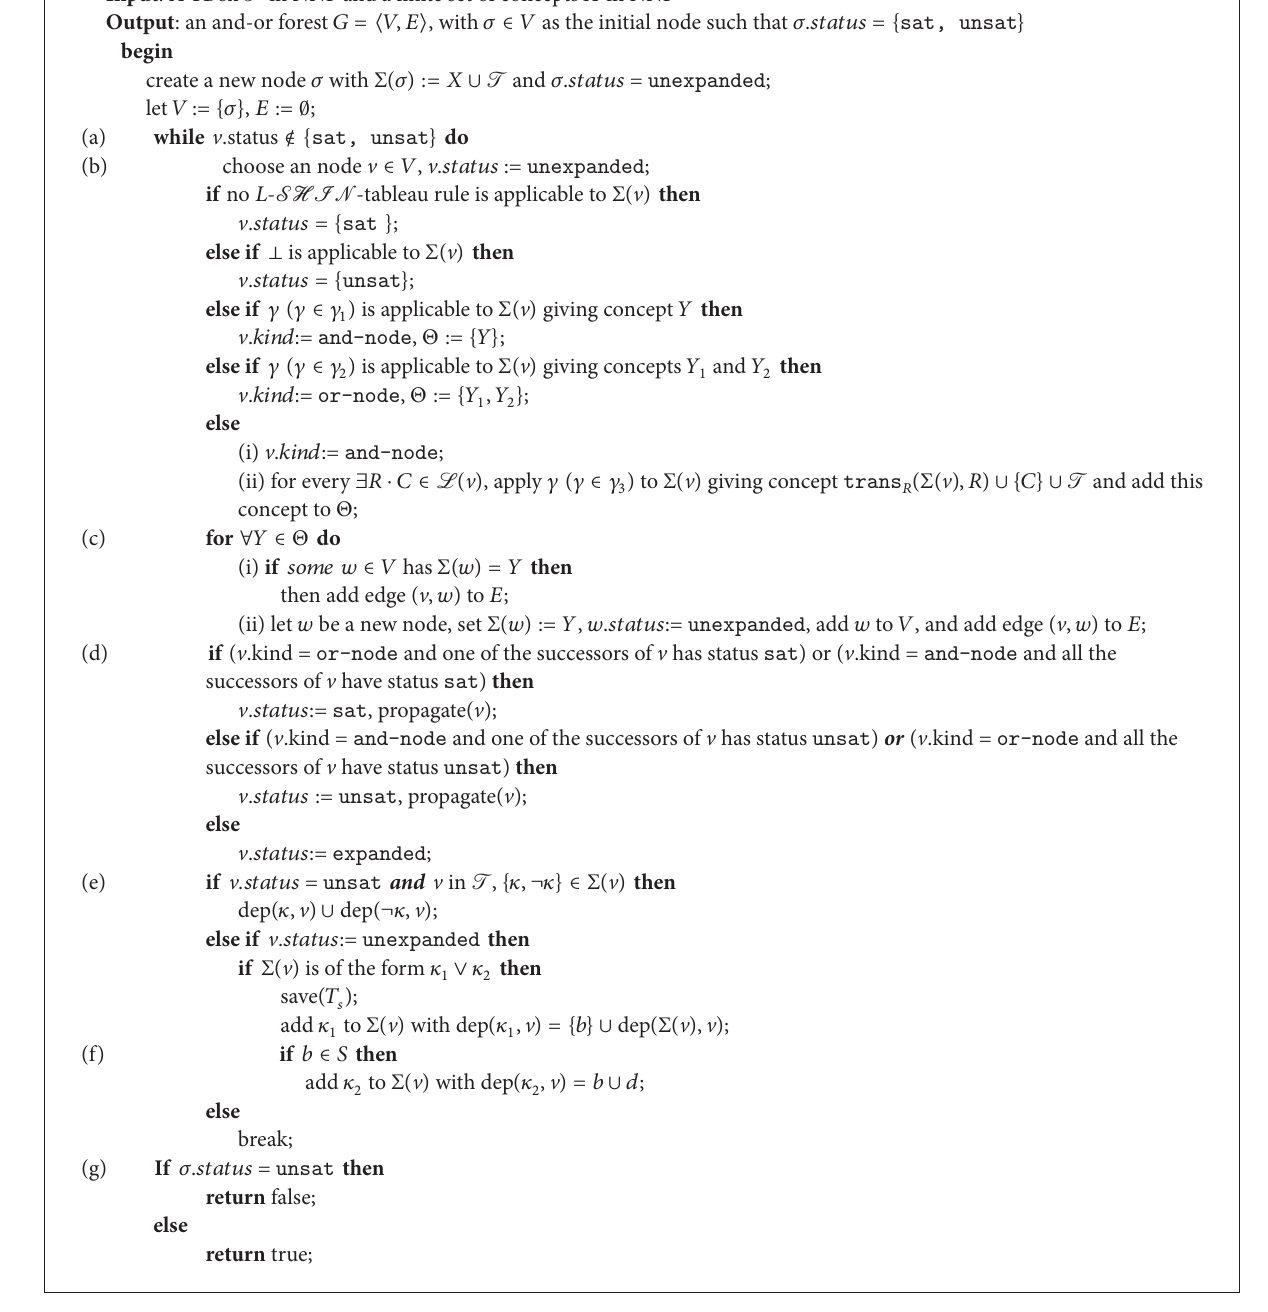
Algorithm 2: A optimized decision procedure for checking satisfiability in 𝐿 - SHIN